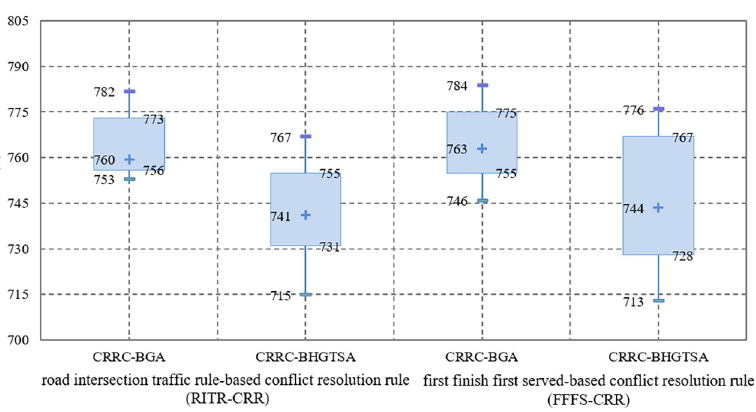
Fig 18. Performance of two bilevel optimization algorithms with each intersection conflict resolution rule for the 14 th experiment.